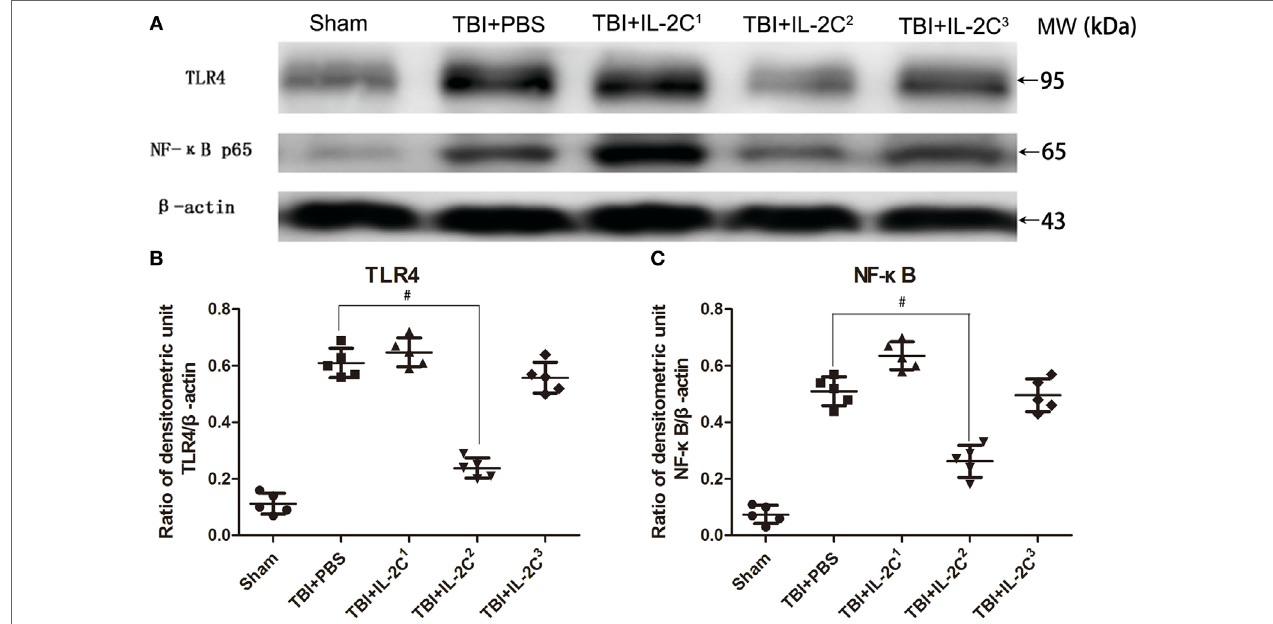
FigUre 2 | (a) Representative immunoblot showing TLR4 and NF- κ B expression on day 3 post-injury in the ipsilateral cortices of mice treated with either PBS or different doses of IL-2C, as indicated. (B,c) Quantitative evaluation showed that IL-2C 2 (0.5 µg IL-2 + 2.5 μ g anti-IL-2) significantly reduced the expression of both inflammatory factors. Data are presented as the mean ± SD; * p < 0.05 and # p <